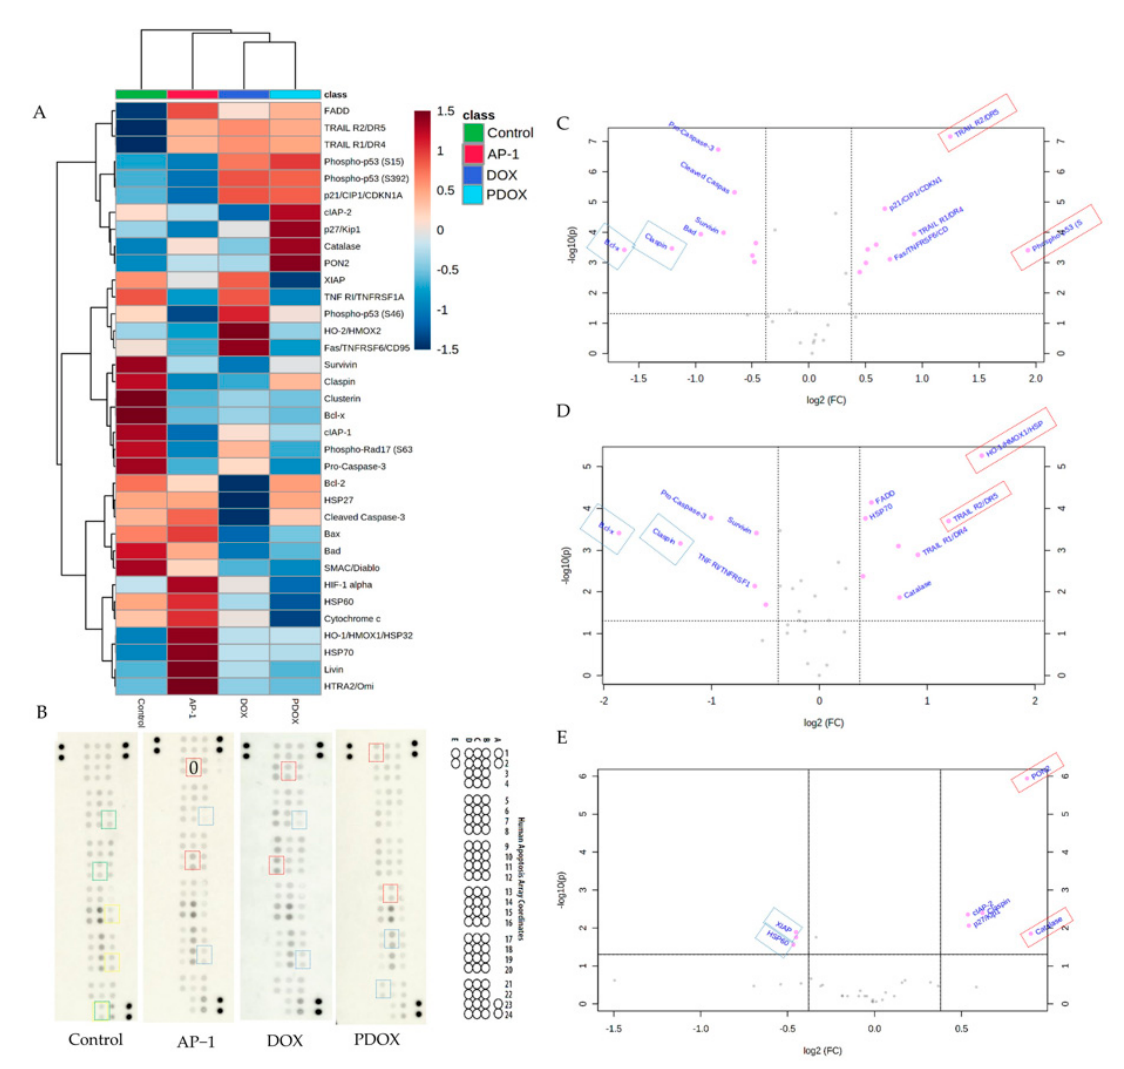
Figure 7. Differently expressed apoptotic proteins in the MCF7 cell lysates after treatment with AP-1, DOX, and the synergistic combination (PDOX). ( A ) Mean apoptotic proteins expression heatmap of the proteome arrays processed data after treatment of MCF7 cells with the vehicle (0.5% DMSO), 0.29 µ g mL − 1 DOX, 100 µ g mL − 1 AP-1 and their synergistic combination with hierarchical clustering of the groups using the Euclidean distance measure and Ward clustering algorithm. ( B ) The MCF7 lysates were analysed by Proteome Profiler TM human apoptotic arrays after 24 h of treatment. The significant features are marked with blue and red rectangles (other than the vehicle control), indicating the downregulation and upregulation of proteins, respectively. The yellow and green rectangles on the control array indicate the significant proteins identified by coefficient and VIP scores of the PLS-DA model, respectively. Protein coordinates are listed in Table S4. ( C ) The significantly dysregulated apoptotic proteins after DOX treatment as selected by volcano plot compared to the control with the fold change (FC) threshold (x) 1.3 and t -test threshold (y) 0.05. ( D ) The significantly dysregulated apoptotic proteins after AP-1 treatment as selected by volcano plot compared to the vehicle control with the FC threshold (x) 1.3 and t -test threshold (y) 0.05. ( E ) The significantly dysregulated apoptotic proteins after treatment with the synergetic combination (100 µ g mL − 1 AP-1 and 0.29 µ g mL − 1 DOX) as selected by volcano plot compared to the vehicle control with the FC threshold (x) 1.3 and t -test threshold (y) 0.05. The fold changes and p values are log-transformed, and the further the FC values are from the (0,0), the more significant the feature